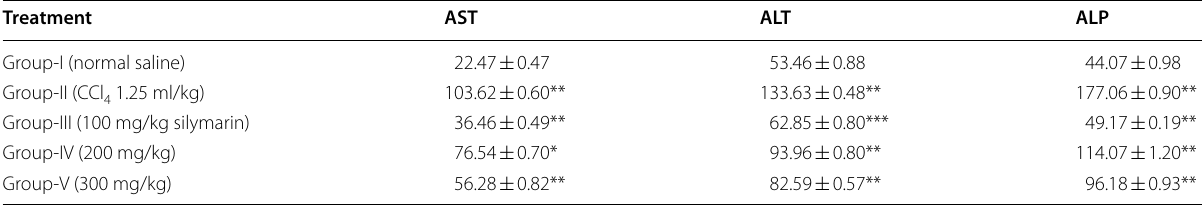
-induced hepatotoxicity in rats 4